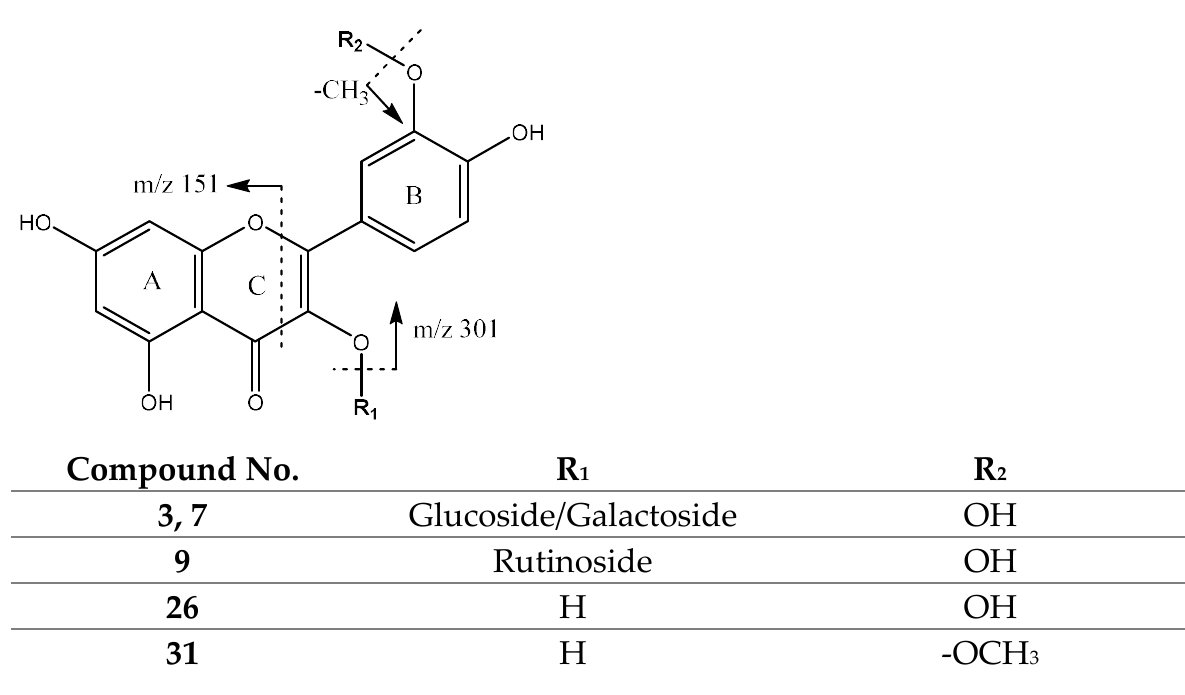
Figure 18. Quercetin derivatives structure and main fragments. assigned to myricetin [42], with its main fragments at m / z 179 from retro-cyclization and